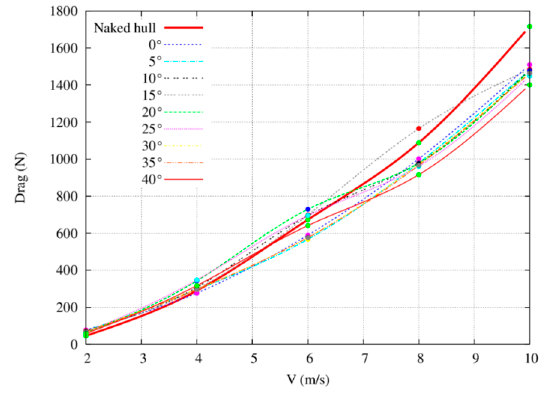
Figure 5. The result of relation between hull resistance and